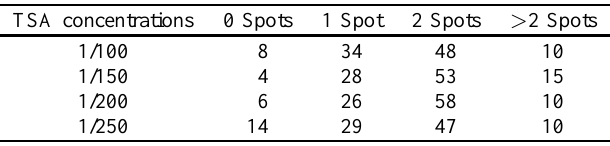
Concentrations are given dilutions of kit stock solution. The values in brackets represent the corresponding standard deviations. Table 4 Effect of the tyramide concentration on automated scoring TSA